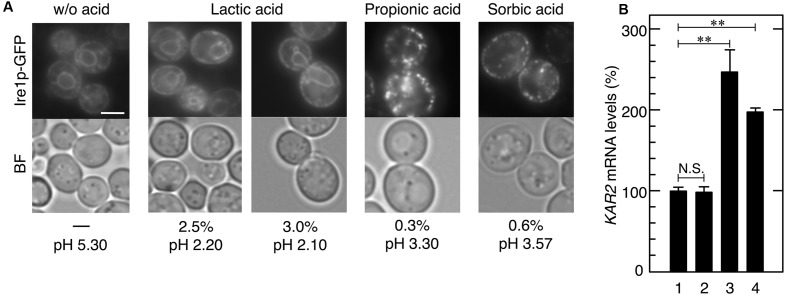
Effects of various carboxylic acids on the induction of UPR. Exponentially growing cells were treated with various carboxylic acids for 30 min. (A) Ire1p-GFP was immediately observed after the treatment without fixation. Representative pictures are shown. BF, bright field. The white bar indicates 3 μm. (B) The mRNA levels of KAR2 were analyzed by qRT-PCR. In order to compare expression levels, the mRNA level of KAR2 was normalized to that of ACT1 under each condition. The mRNA level in cells without a stress treatment was considered to be 100%. Data are shown as the mean ± standard error (n = 3). Lane 1, w/o stress; lane 2, 3.0% lactic acid, lane 3, 0.3% propionic acid; lane 4, 0.6% sorbic acid. ∗∗P-value < 0.01. N.S., no statistically significant difference.